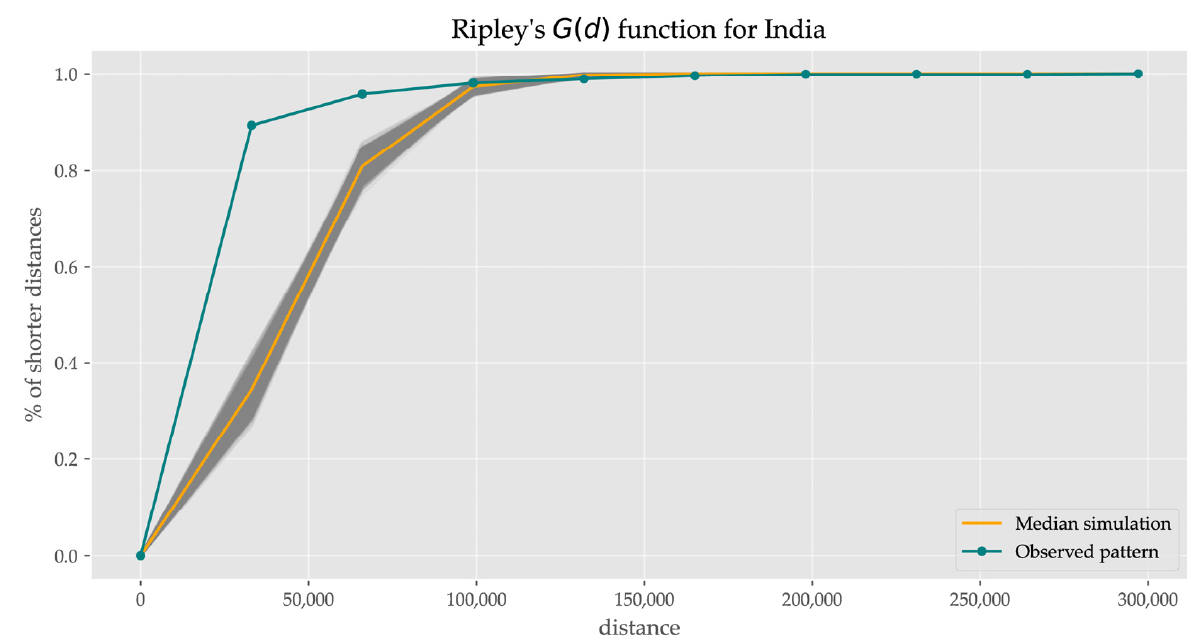
Figure 17. Ripley’s G(d) function for India.